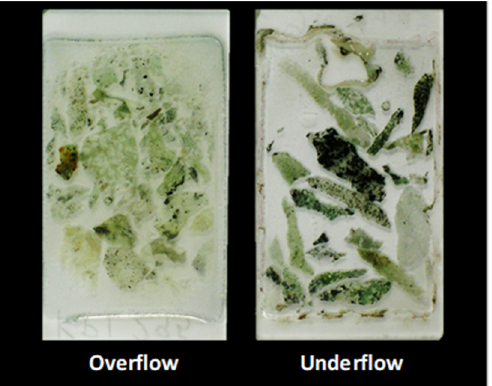
Figure 11. Illustration of the variation in shape of particles recovered to the overflow and underflow at the DMS cut-point for ore A. Thin section glass slides are 46 mm × 26 mm in size.